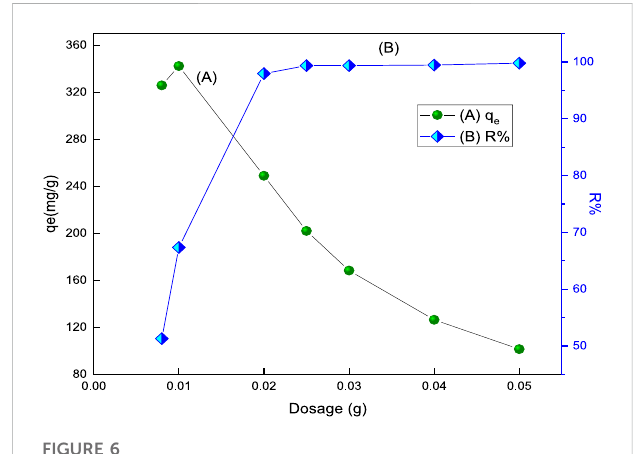
FIGURE 6 Effect of adsorbent, CM- β CD:nChi:Glu, dosage on (A) the adsorption capacity and (B) % removal (R%) of acid red 37 (102.2 mg L − 1 dye solution for 30 min at 250 rpm and optimum